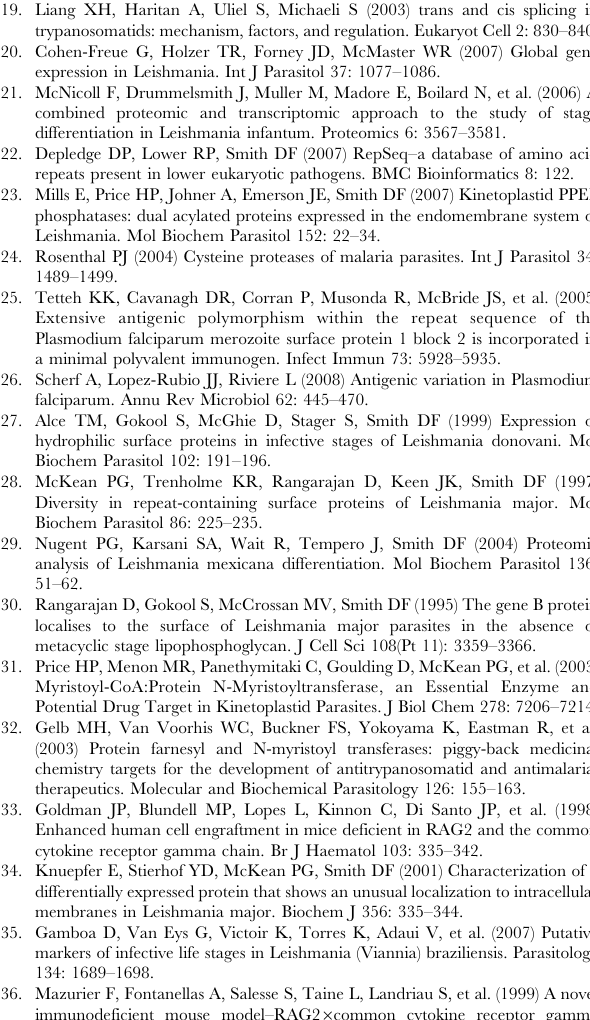
Table S1 List of genes differentially distributed between three Leishmania species with microarray analysis derived from this study or ref [14]. Table S2 All 70-mer oligonucleotides used in the microarray studies reported in Depledge et al., 2009. Table S3 List of primers used in qPCR validation of microarray data.